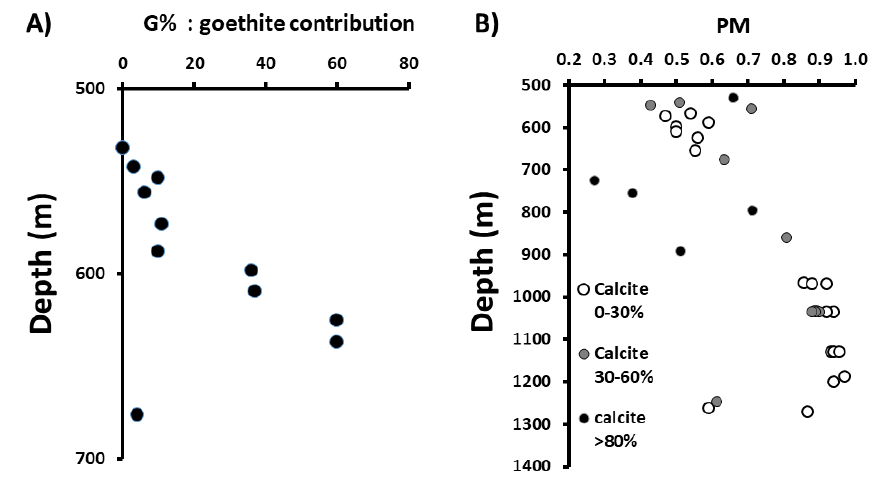
Figure 7. ( A ) Proxy of goethite (G%) versus depth for Borehole EST433. For depths >700 m, G% was negligible. ( B ) PM parameter versus depth; calcite content is indicated.